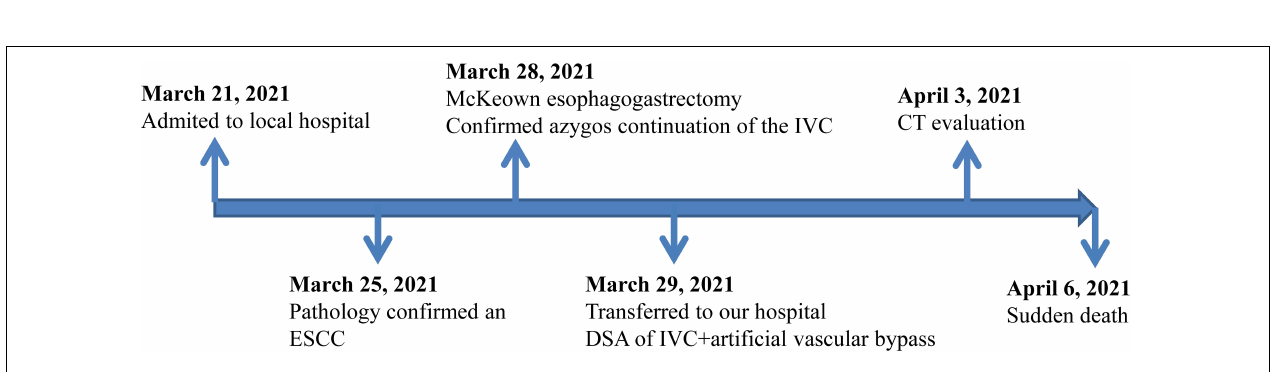
FIGURE 3 | Timeline of events of the patient from admission to